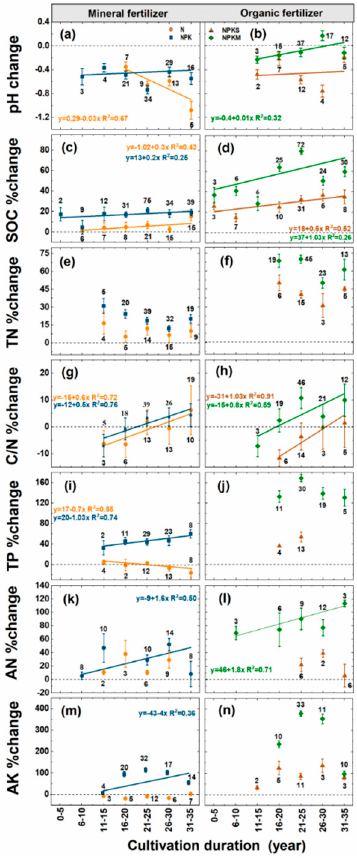
Figure 5. The effects of mineral fertilizers (N, NPK (phosphorus, potassium and nitrogen)) and organic fertilizer (NPKS (NPK with straw returning), NPKM (NPK with manure)) on soil chemical properties (pH ( a , b ), SOC ( c , d ), TN ( e , f ), C/N ( g , h ), TP ( i , j ), AN ( k , l ), AK ( m , n )) with the cultivation duration (SOC: soil organic carbon. TN: total nitrogen. C/N: organic carbon − nitrogen ratio. TP: total phosphorus. AN: alkali − hydrolysable nitrogen. AK: available potassium). Circle: N. square: NPK. triangle: NPKS. diamond: NPKM. The numbers near the points and whiskers indicate the data numbers. Change and % change were compared to the control. Points and whiskers are mean values with the standard error.